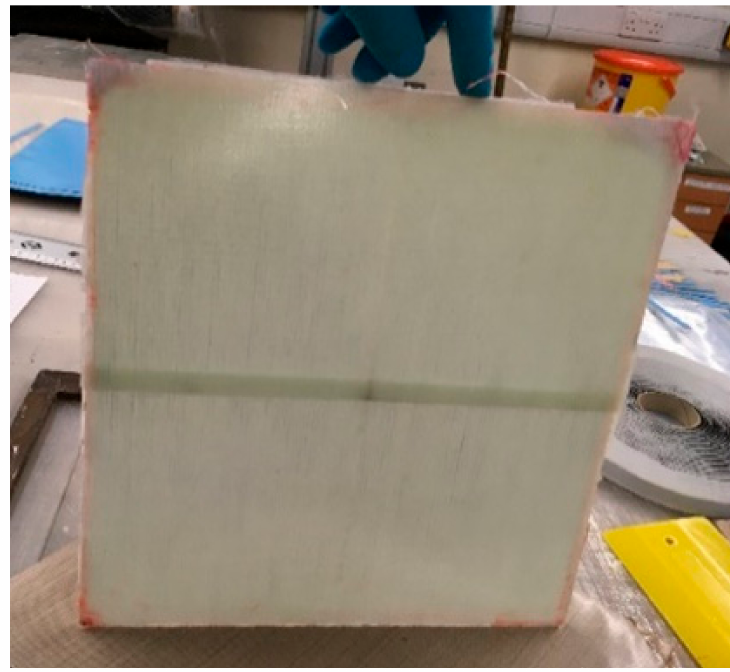
Figure 5. Photo of co-cured plate (case